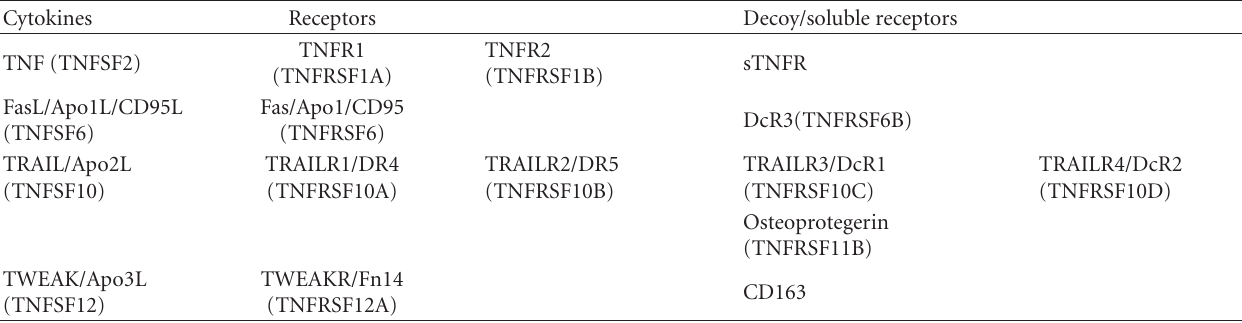
Table 1: TNF superfamily cytokines and receptors involved in kidney injury. Common names as well as TNFSF and TNFRSF numbers are